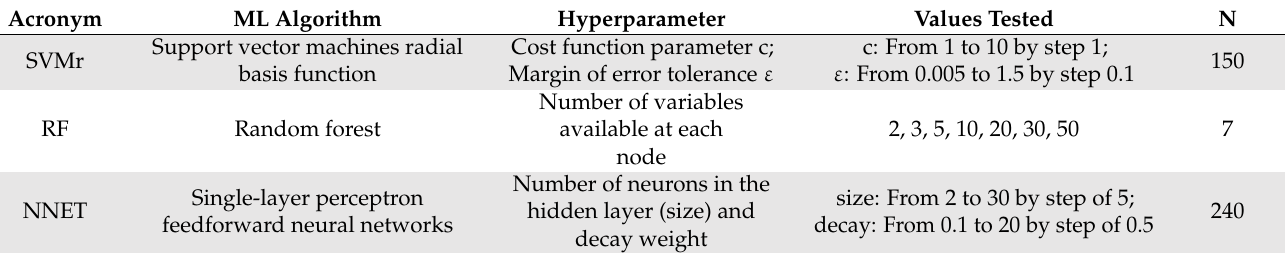
Table 4. Algorithm hyperparameters tuned, and the range of values tested for each of them. N is the total number of hyperparameter combinations tested for each